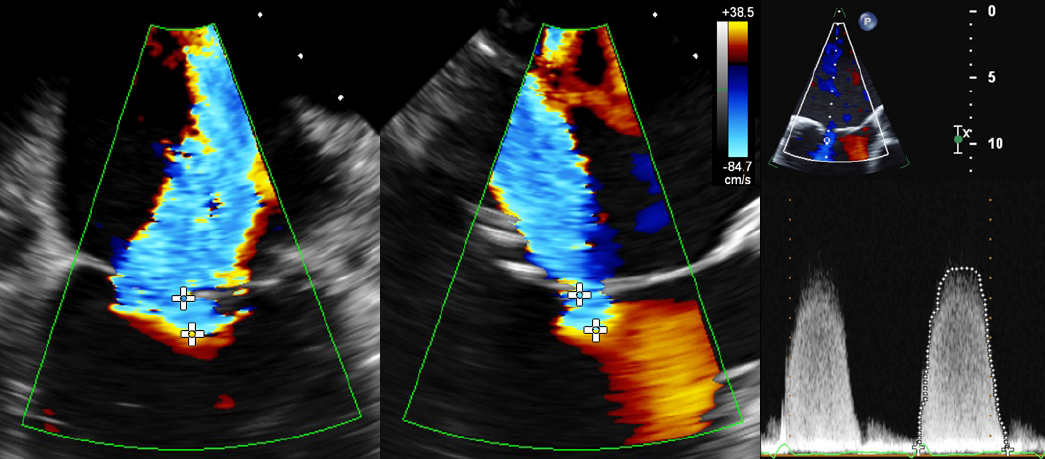
Figure 2. Determination of 2D PISA in biplane 2D color Doppler dataset and CW Doppler dataset. Echocardiographic images with 2 orthogonal slice planes of the 2D color Doppler dataset (mid-systolic) with Nyquist velocity of 38.5 cm/s ( left ); determination of PISA radius in 2 planes (diameters with crosses), MR-VTI (do tt ed outline), and MR-Vmax in the CW Doppler dataset ( right ) for calculation of regurgitation area. Abbreviations: 2D = two-dimensional; PISA = proximal isovelocity surface area; CW = continuous wave; MR-VTI = mitral regurgitation velocity–time integral; MR-Vmax = maximum mitral regurgitation velocity.